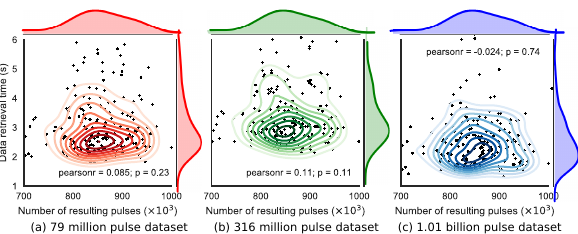
Figure 10. Data retrieval from HBase for large